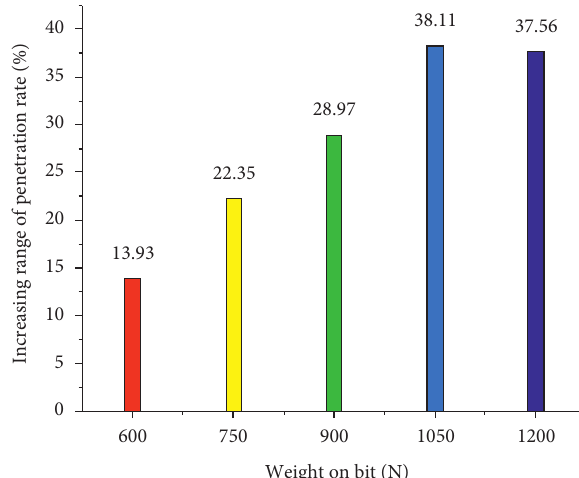
Figure 15: The relationship between WOB and the increase of ROP.